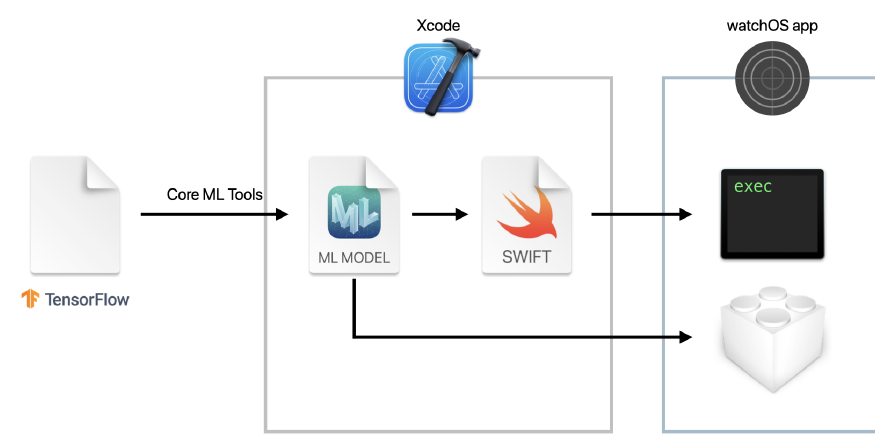
Figure 8. Conversion workflow for using a model on watchOS.